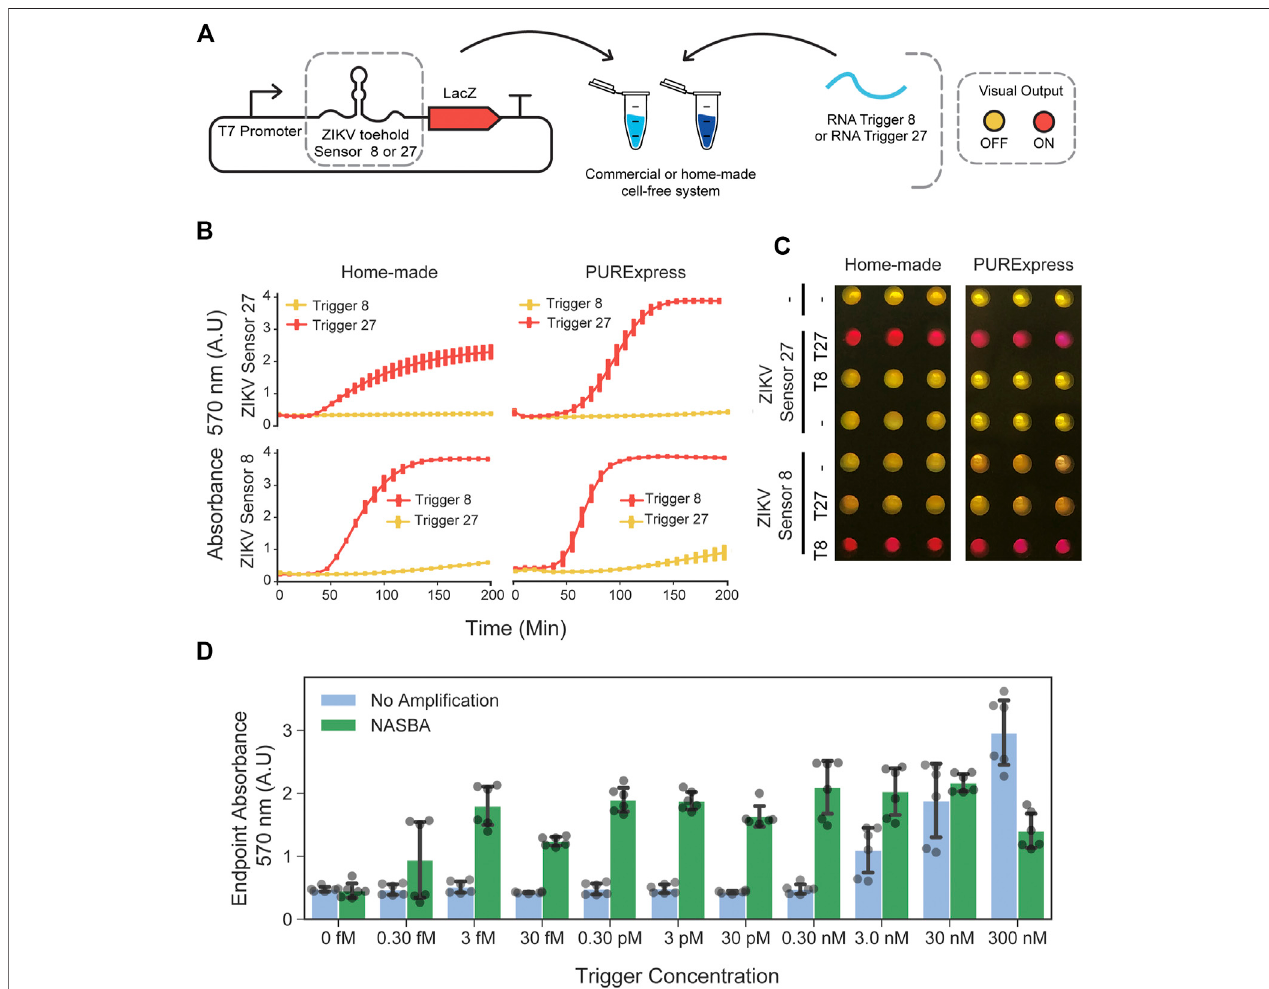
FIGURE 2 | Performance of ZIKV toehold sensors in low-cost cell-free lysate reactions. (A) Schematic representation of toehold-mediated RNA sensing. (B) Dynamics of the RNA sensing reactions performed with ZIKV toehold sensor 8 (0.7 nM plasmid DNA) and 27 (2 nM plasmid DNA), regulating the expression of the full- length LacZ in home-made cell extracts and PURExpress cell-free reactions. Error bars represent the standard deviations of three independent experiments, dots are centered at the arithmetic mean for each time point. (C) Example of the endpoint visualization of the experiments after 4 hours of incubation at 29 ° C. (D) Endpoint measurement of RNA sensing reactions performed with ZIKV sensor 27 and trigger 27 in a range of concentrations with and without NASBA isothermal ampli fi cation. Gray dots represent data from six independent measurements performed from two independent NASBA ampli fi cations performed on different days. Black error bars correspond to standard deviations of these six